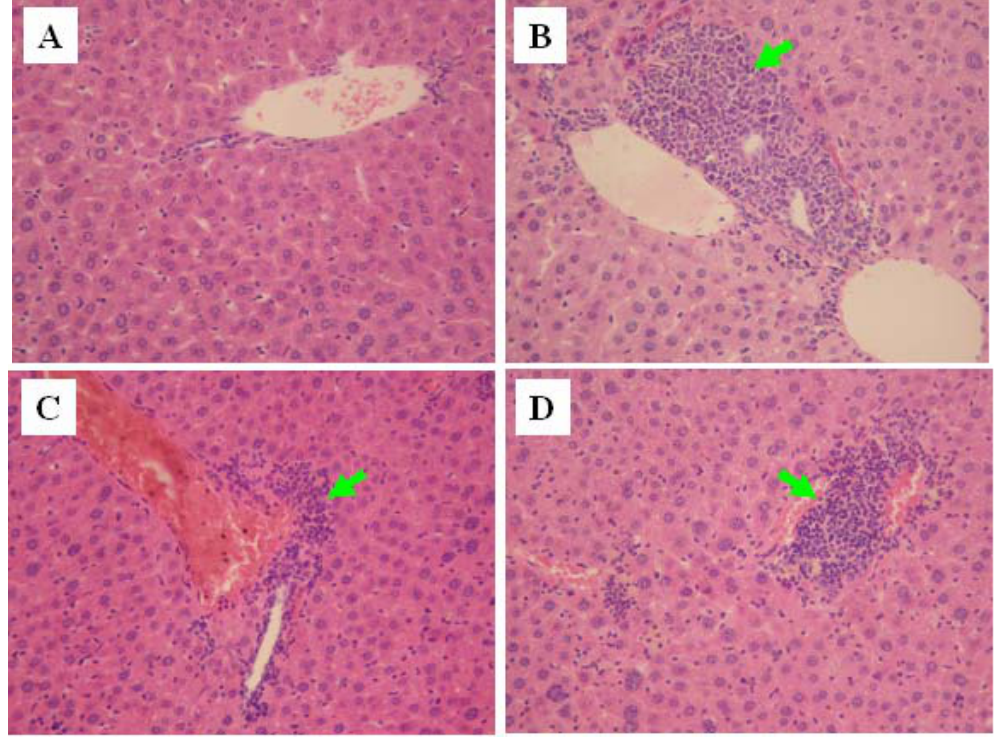
Figure 6. Histopathology of the liver (×100). ( A ) Normal control; ( B ) Treated with CCl ( C ) Treated with CCl + G-M1 (30 mg/kg/day); ( D ) Treated with CCl 4 (300 mg/kg/day). The arrow represents leukocytes with